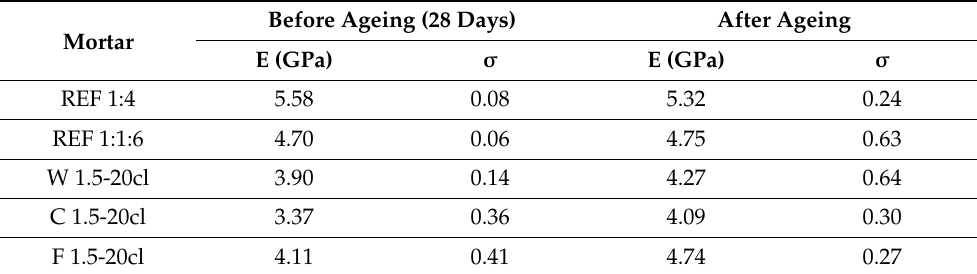
Table 2. Modulus of elasticity by ultra-sound pulse velocity.